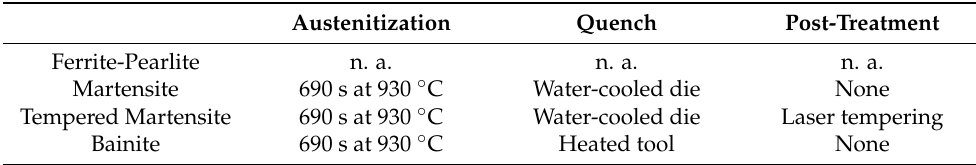
Table 2. Summary of heat treatment conditions applied.